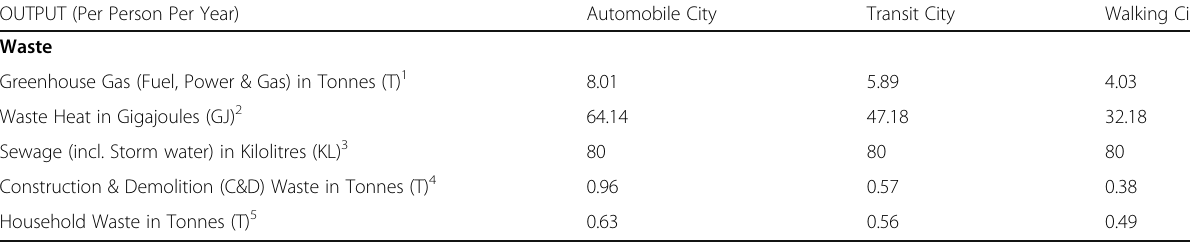
Table 2 Waste output variations between urban form types (Source: [43]) OUTPUT (Per Person Per Year)